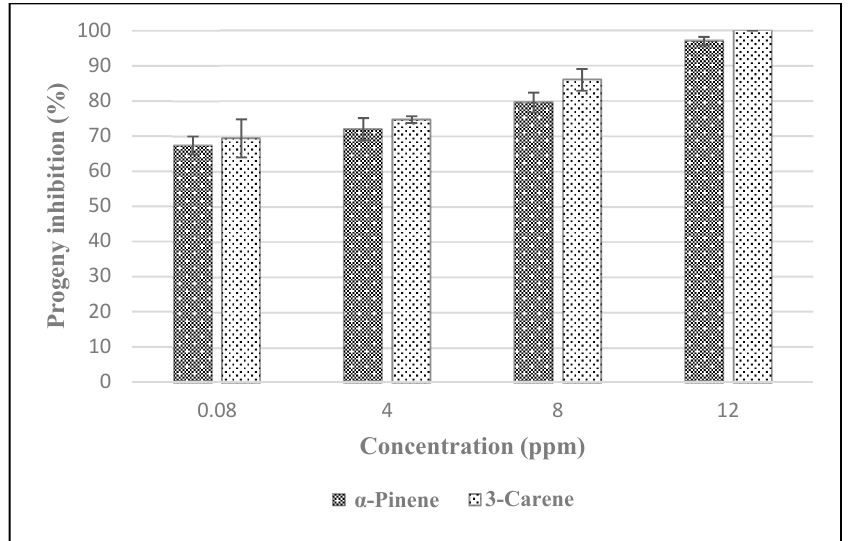
Figure 1. Reduction of Sitophilus zeamais progeny production due to treatment of stored maize with α -pinene and 3-carene by contact.